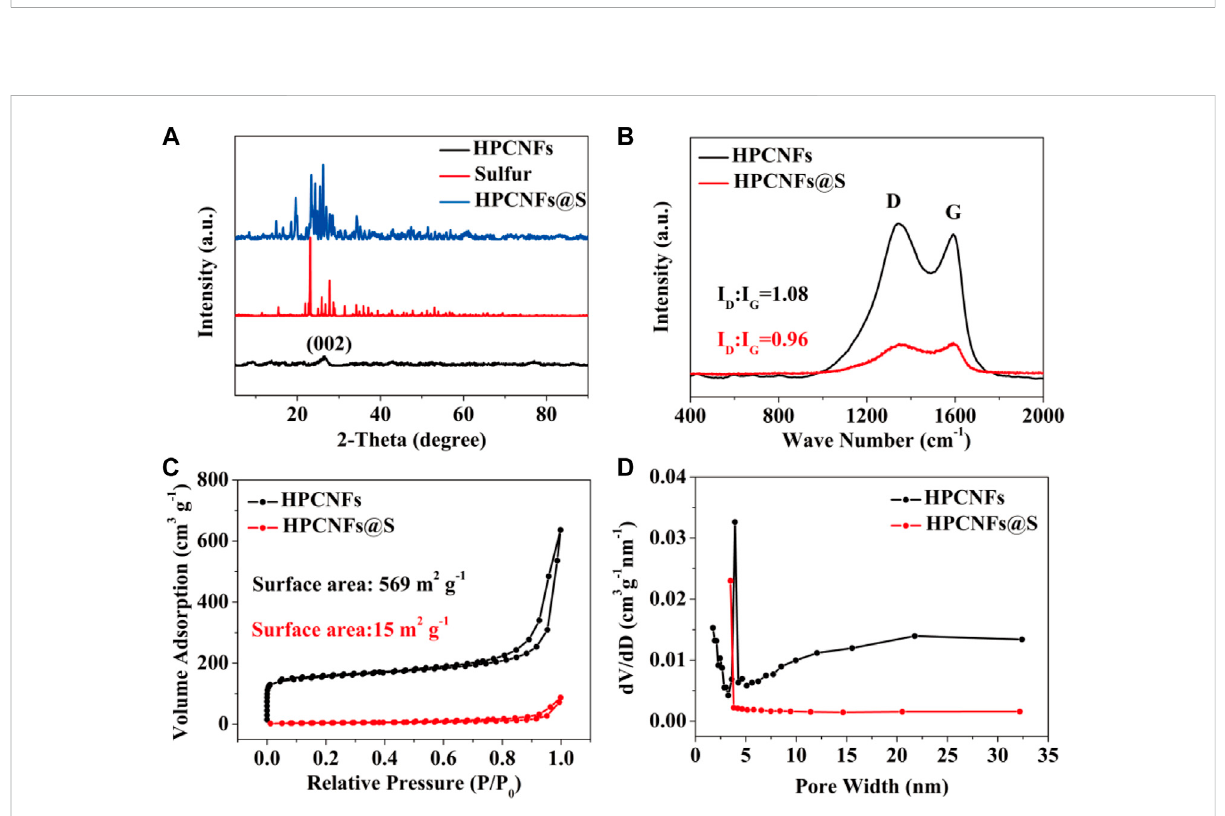
FIGURE 3 (A) XRD patterns of HPCNFs, sulfur, and HPCNFs@S; (B) Raman patterns of HPCNFs and HPCNFs@S; (C) nitrogen adsorption and desorption isotherms; (D) pore size distribution of the HPCNFs and